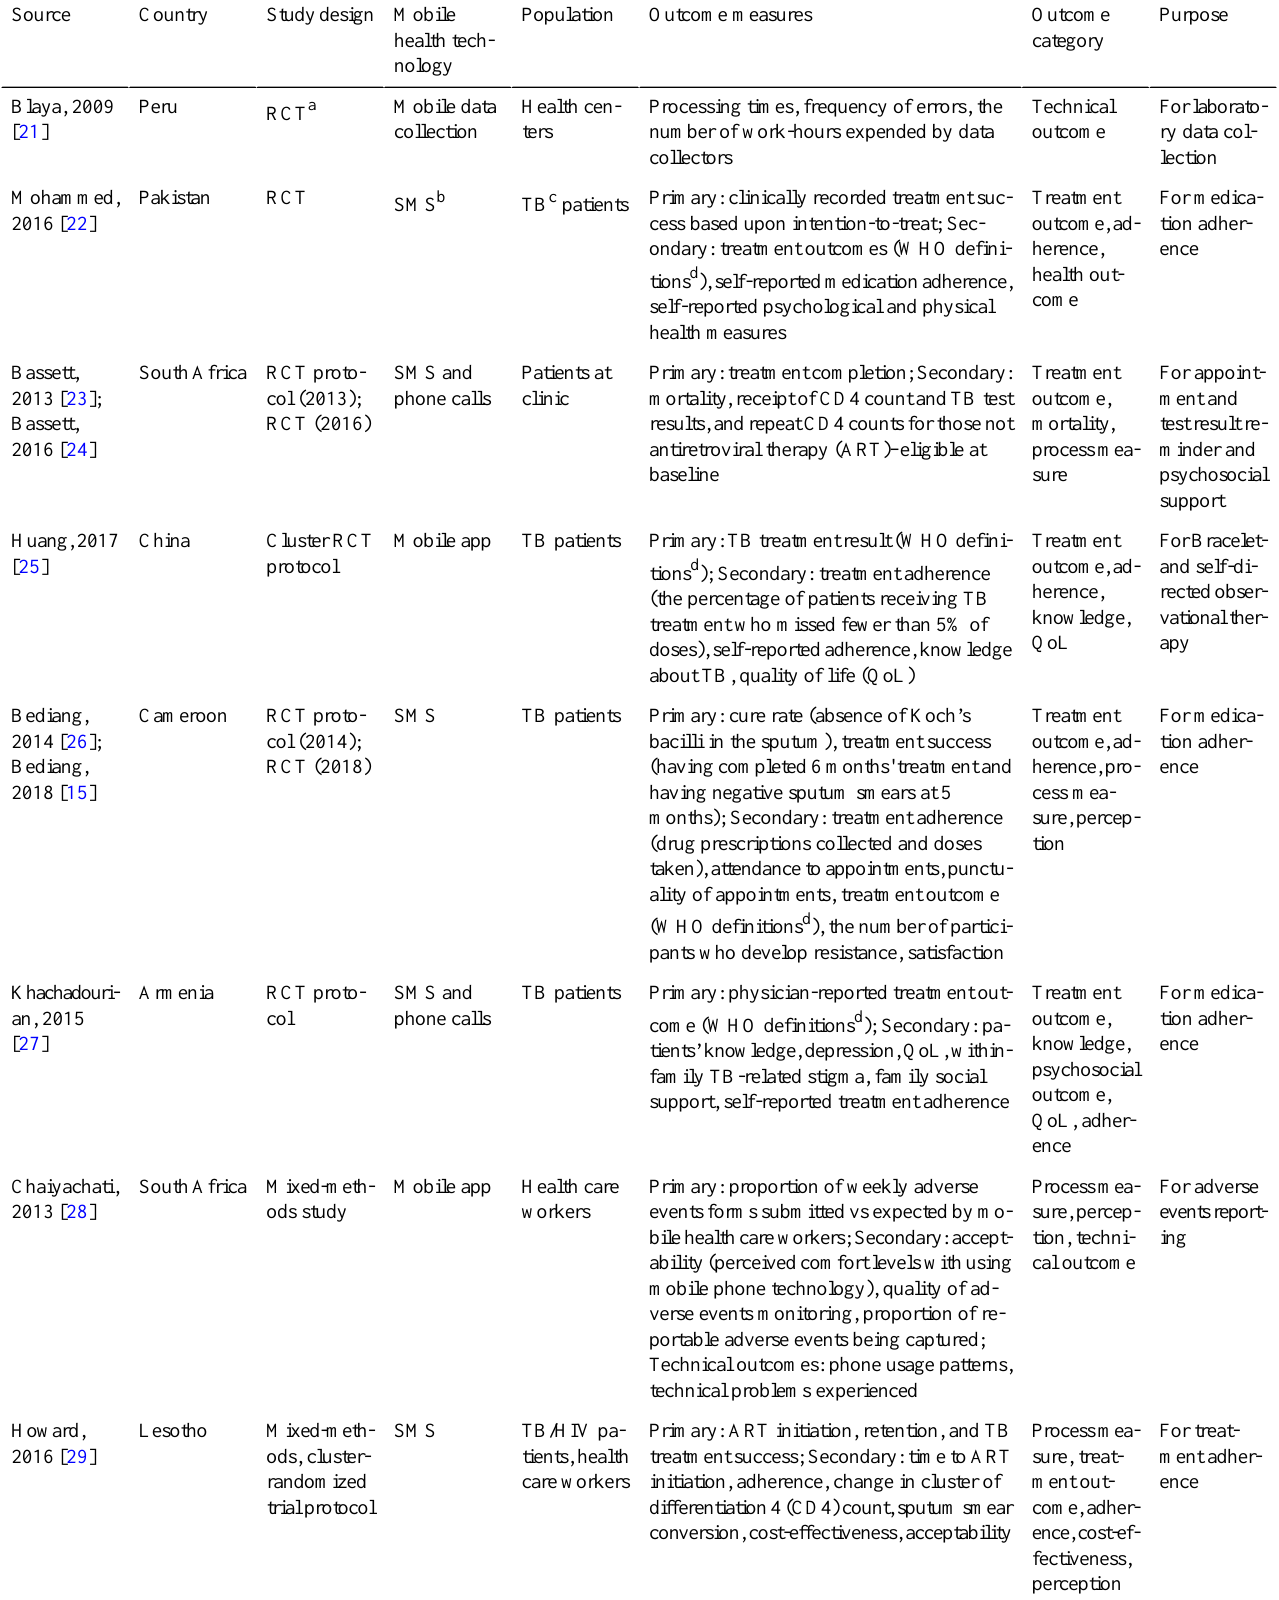
Table 1. Summary of included